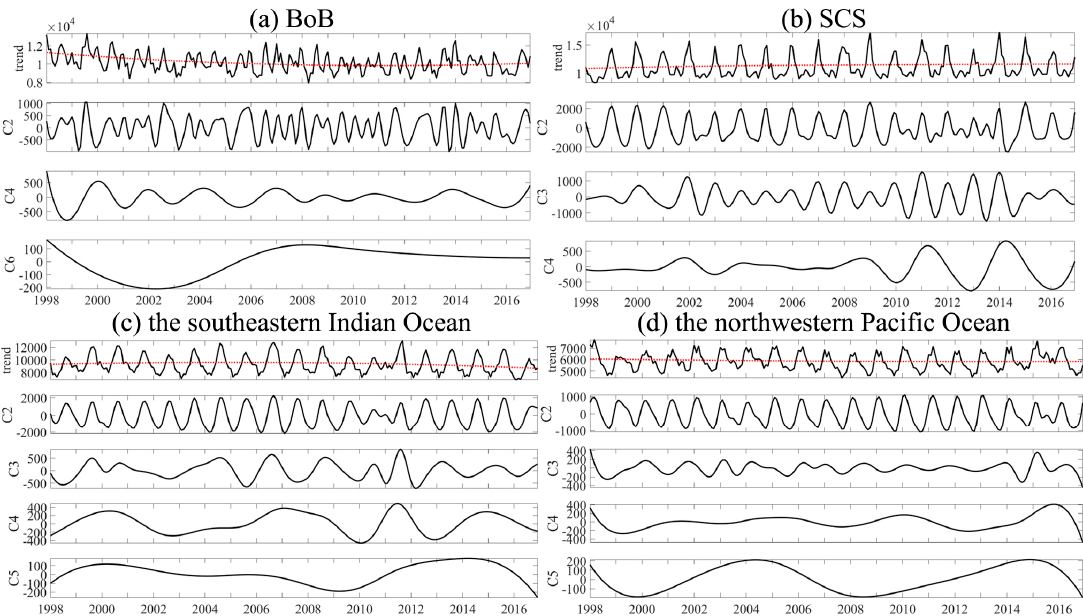
Figure 7. Raw time series (solid line in the top panel), trend (dashed red line in the top panel), and the significant IMFs for domain-averaged NPP (mg C/m 2 /month) in the ( a ) BoB, ( b ) SCS, ( c ) southeastern Indian Ocean, ( d ) northwestern Pacific Ocean. Table 3. The mean periods and variance contribution rates of the significant IMFs for domain-averaged NPP in the BoB, SCS, southeastern Indian Ocean, and northwestern Pacific Ocean.